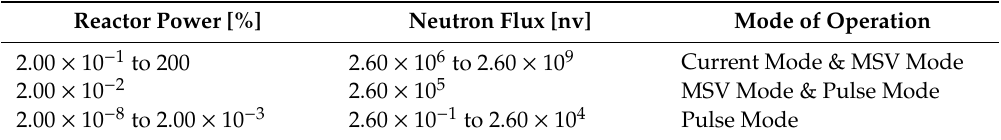
Table 2. The relationship between the reactor power and the neutron flux.